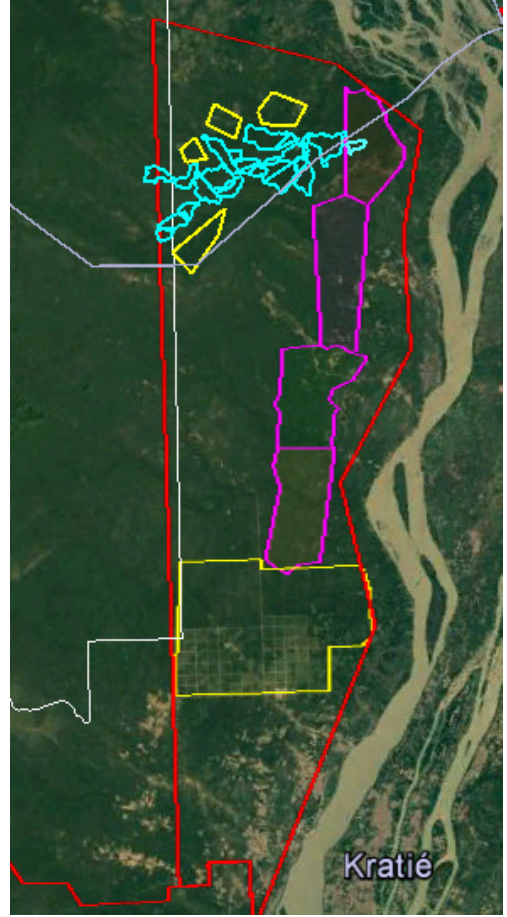
Figure 9. Google Earth screen shot with shape files. Pink are CFs and yellow is cleared company area as of September 2016. Affected area boundaries created using GPS data points collected by PLCN and author in September 2016. CF shape files are from Cambodia’s Forest Administration (FA).